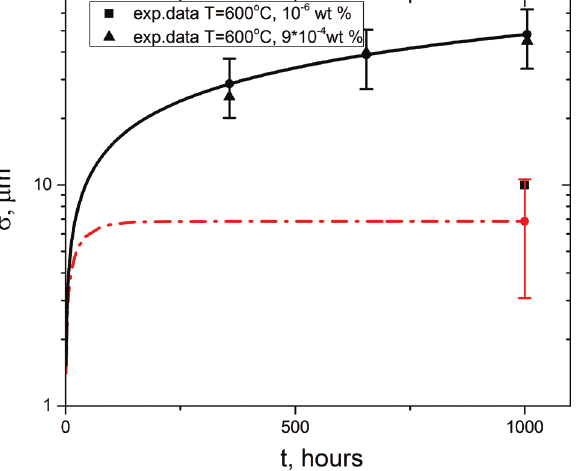
Figure 11. Calculated results and experimental data for steel T91 (Weisenburger et al. 2011). The estimated error is